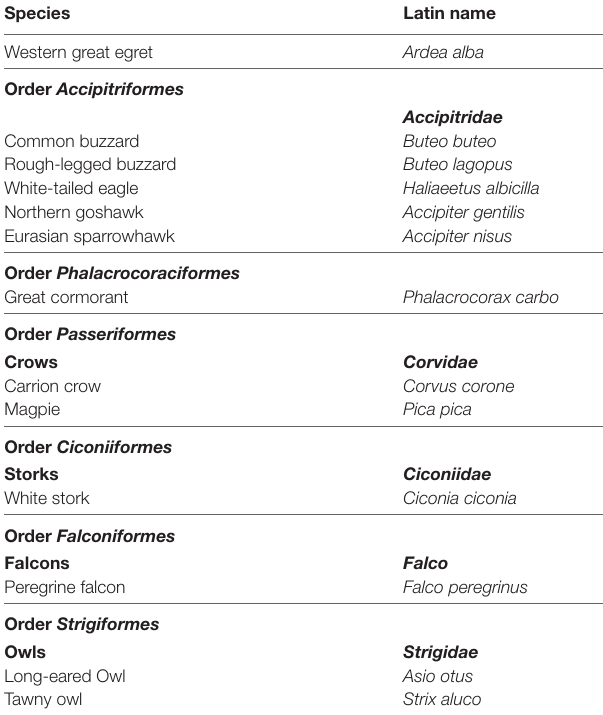
TaBle 1 | Species of wild or feral (marked with *) birds infected with HPAIV clade 2.3.4.4b